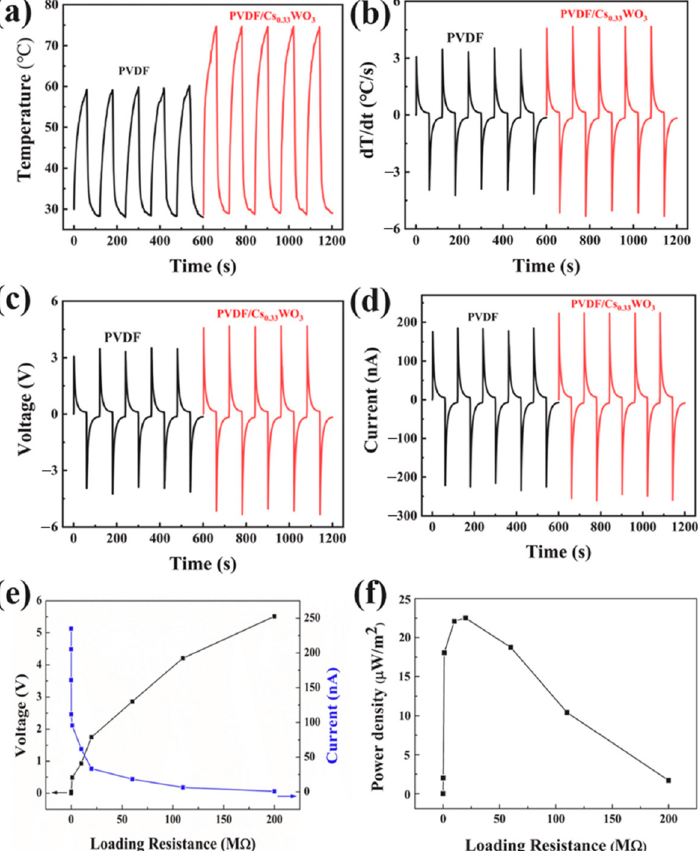
Figure 17. The thermal and electrical output performance of the PyNG developed by Gokana et al. [91]. ( a ) Temperature variation, ( b ) rate of temperature shift, ( c ) output voltage, and ( d ) output current of both pure PVDF PyNG and PVDF/Cs 0.33 WO 3 PyNG. ( e ) Output voltage and current of PVDF/Cs 0.33 WO 3 PyNG as a function of load resistance. ( f ) Output power density of PVDF/Cs 0.33 WO 3 PyNG as a function of load resistance. Reprinted with permission from [91]. Copyright ©2022, Elsevier B.V.